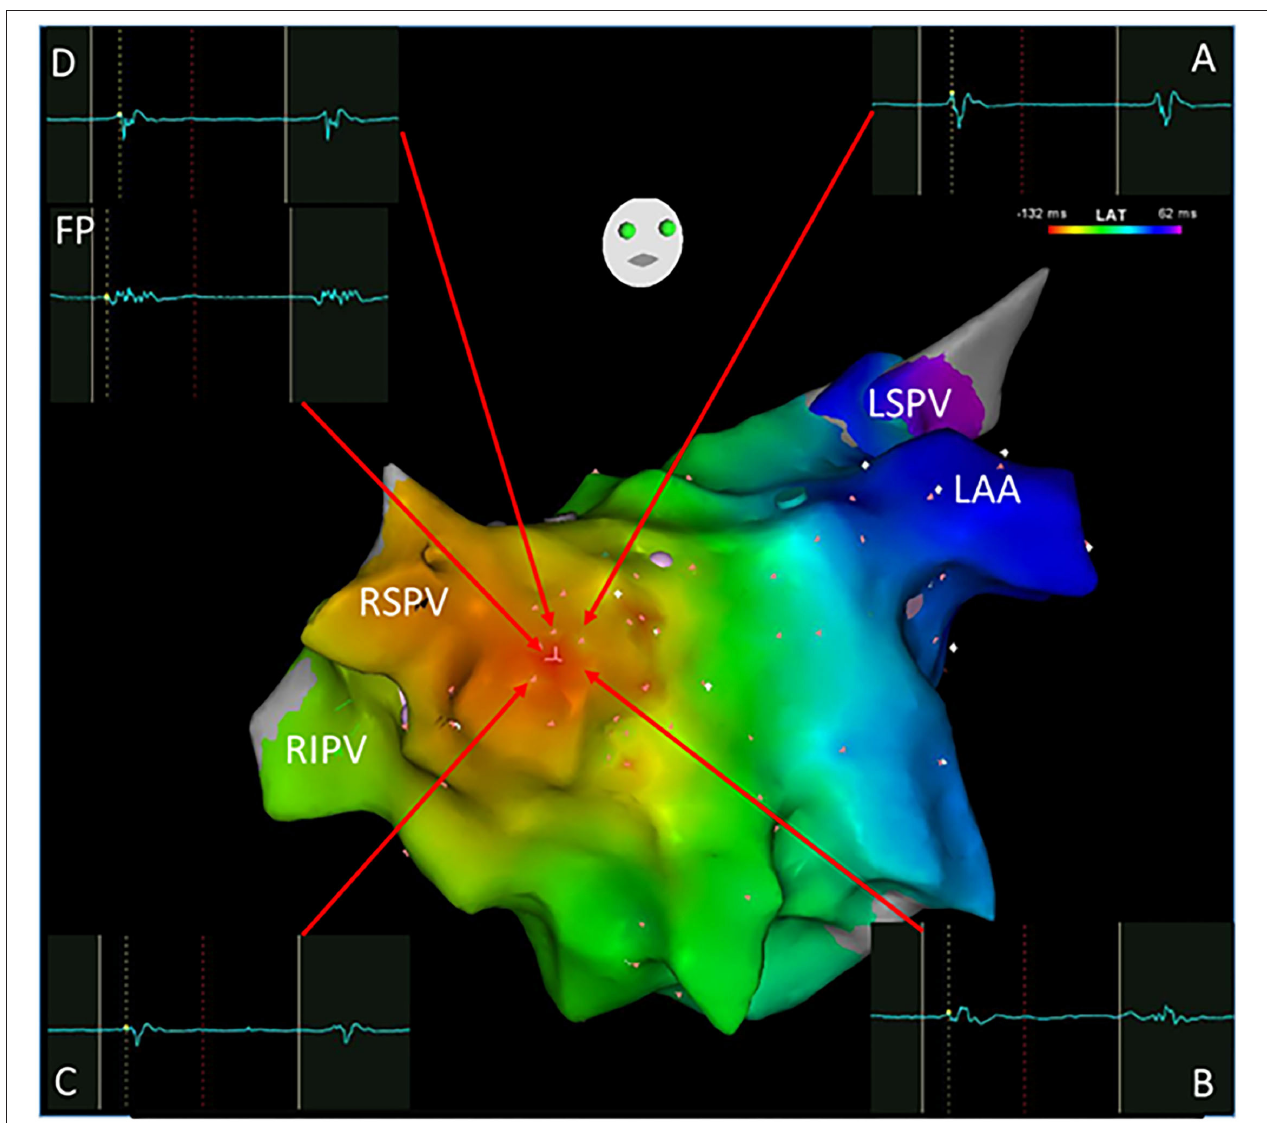
FIGURE 2 | A focal atrial tachycardia located in front of the right superior pulmonary vein with a radiation activation pattern was mapped using the Carto system. The earliest activation point was shown with an FP (-132ms) as the ablation target. Cross-mapping was employed with local activation time at sites A, B, C, and D for -120,-122,-122, and -122ms, respectively. FP, fractionated potential; LAA, left atrial appendage; LSPV, left superior pulmonary vein; RSPV, right superior pulmonary vein; RIPV, right inferior pulmonary